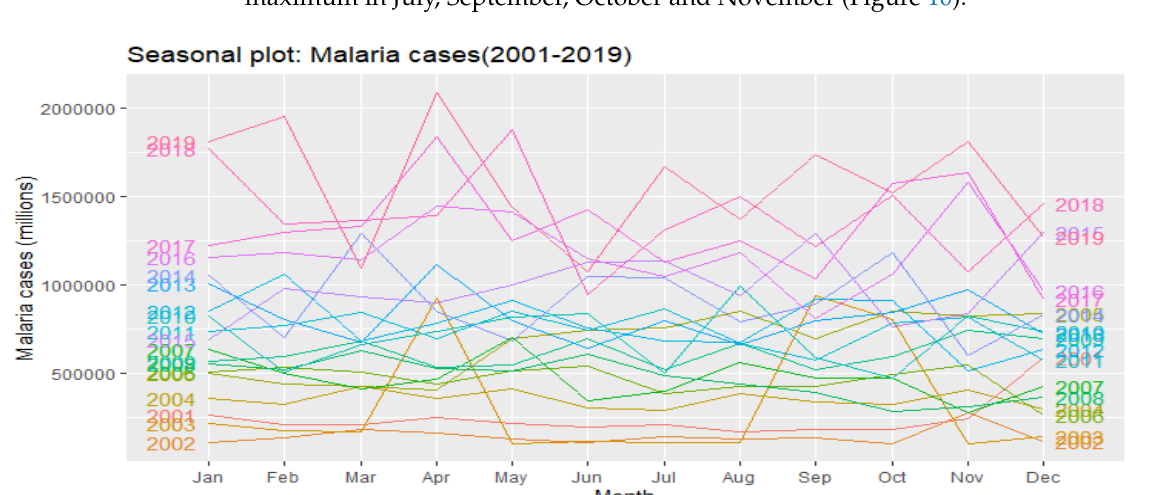
Figure 10. Seasonality of malaria episodes in DRC from 2001 to 2019.